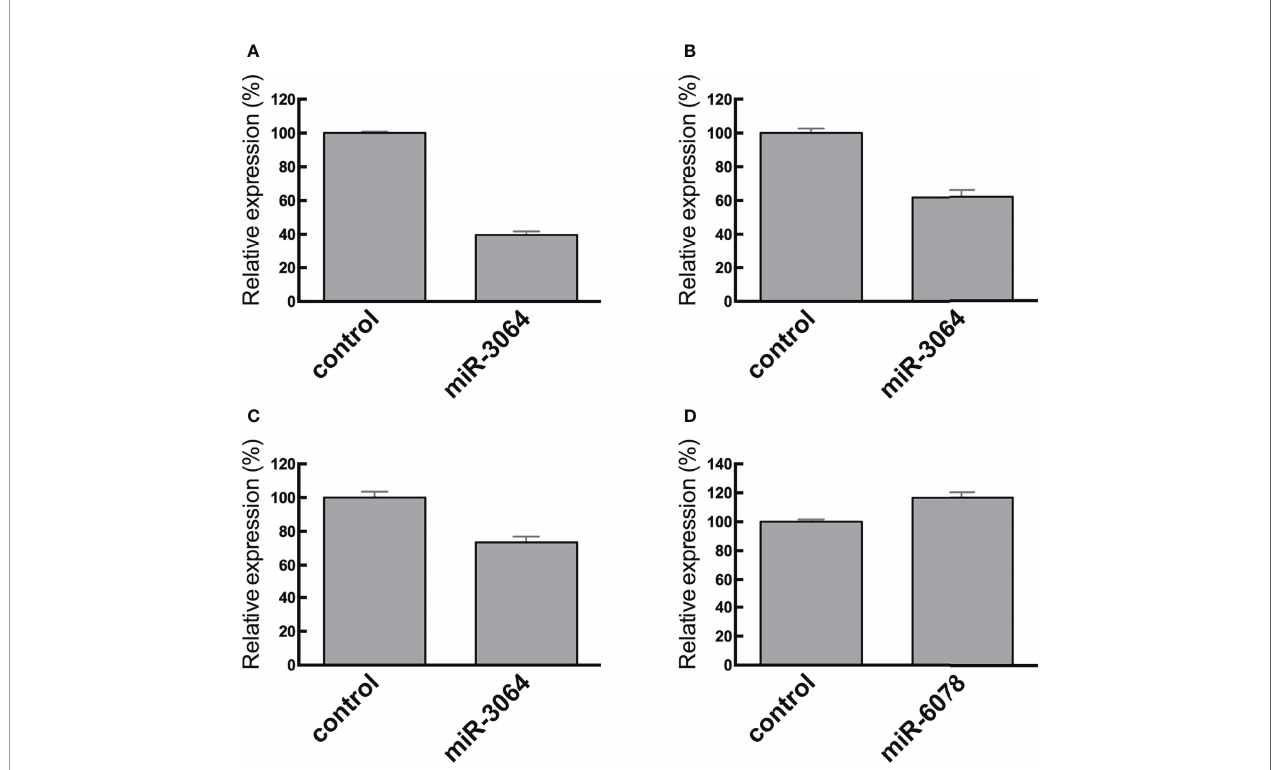
FIGURE 6 | RT-qPCR analysis of SH3BGRL3 (A – C) and ZG16 (D) in normal colon tissues and CRC cell lines. Relative reduced expression of SH3BGRL3 in DLD1 cells after transfection of the miR-3064 mimic. (B) Relative reduced expression of SH3BGRL3 in RKO cells after transfection of the miR-3064 mimic. (C) Relative reduced expression of SH3BGRL3 in Colo320 cells after transfection of the miR-3064 mimic. (D) Relative high expression of ZG16 in CaCO2 cells after transfection of the miR-6078